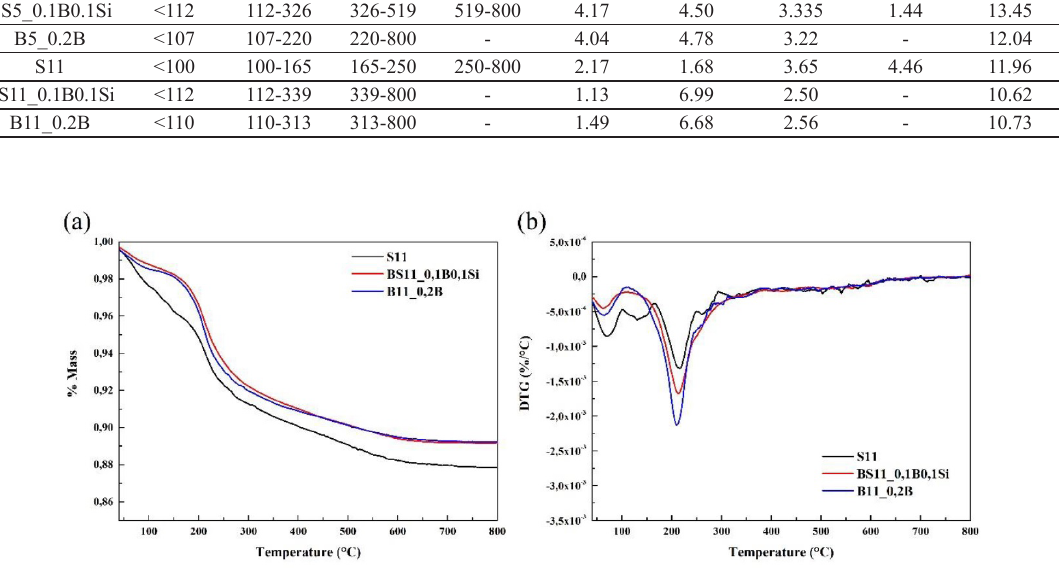
Figure 8. Profiles of (a) TG and (b) DTG of samples S11, BS11_0,1B0,1Si and B11_0,2B.